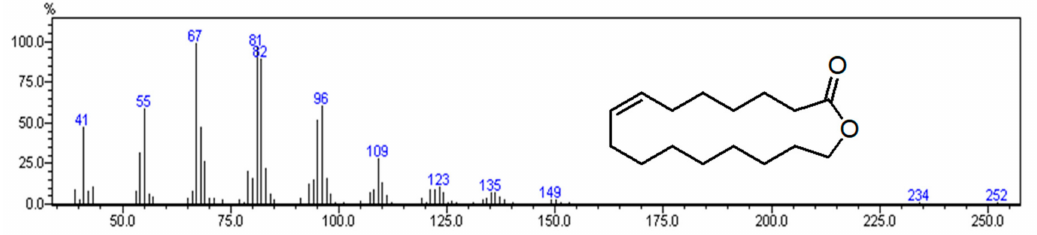
Figure 2. Mass spectrum and chemical structure of ( Z )-Oxacycloheptadec-8-en-2-one (LRI 1914–2385) found in the present